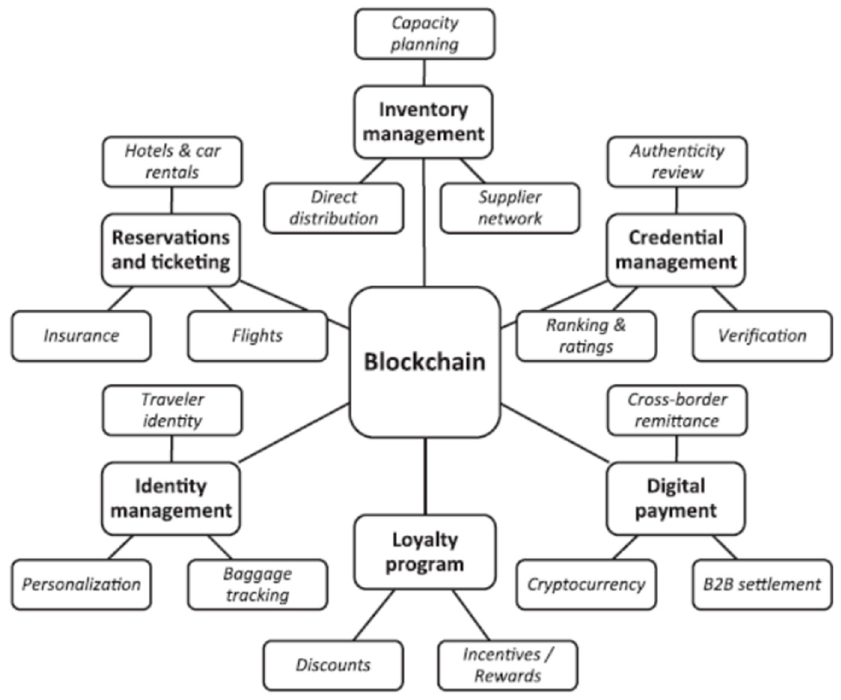
Figure 2. Overview of key blockchain applications to enhance tourism [43] (p. 3).